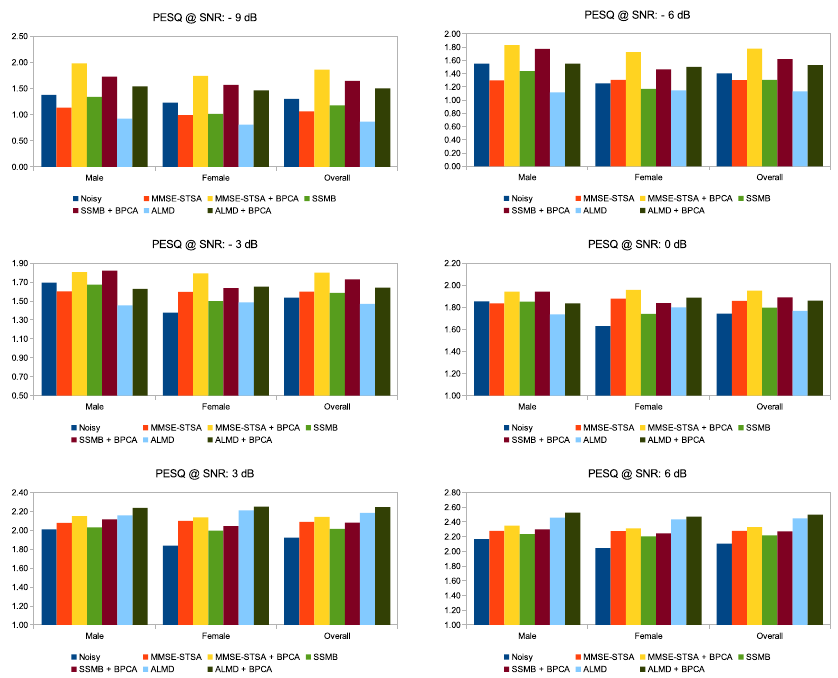
Figure 7. Average PESQ scores for male and female speakers under ‘Babble’ noise contamination over multiple SNR levels. (For interpretation of the bar colors, the reader is referred to the web version of this article).